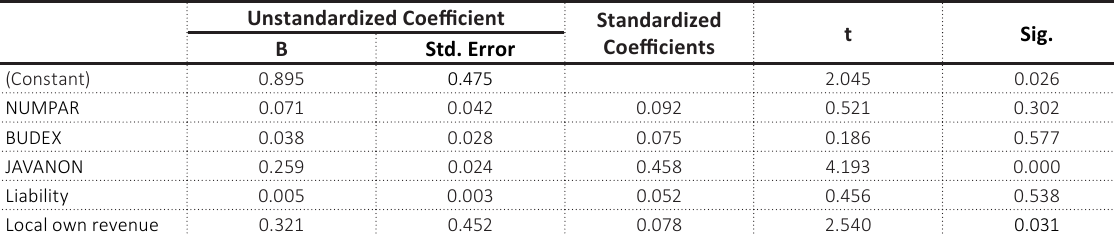
Table 4. Multiple regression